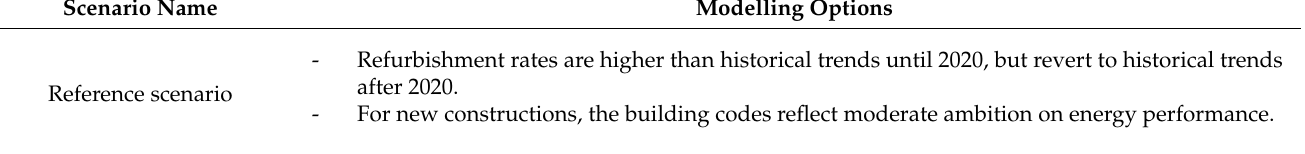
Table 3. Summary of the scenario